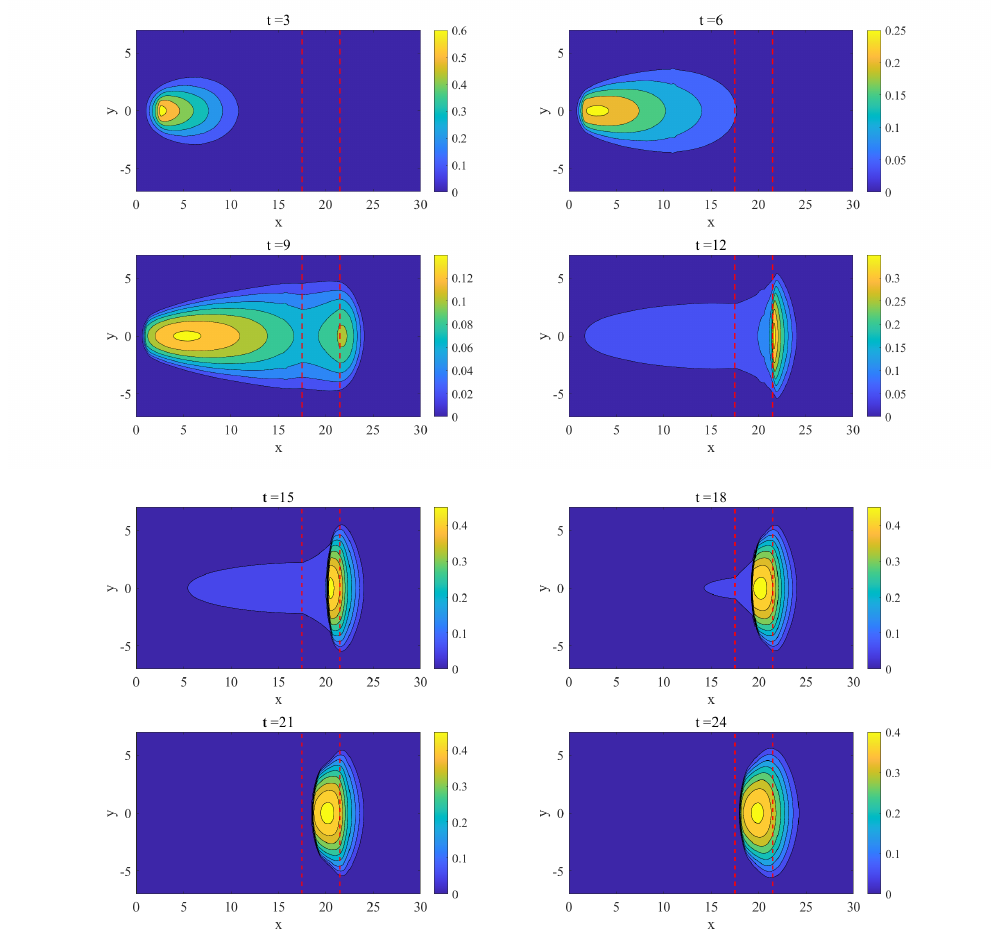
Figure 11. Thickness contours of the avalanche at t = 3,6,9,12,15,18,21,24 for the flow sliding down the inclined plane and merging continuously into a horizontal plane. The transition zone from the inclined plane to the horizontal plane lies between the two red dashed lines. The HLL flux is